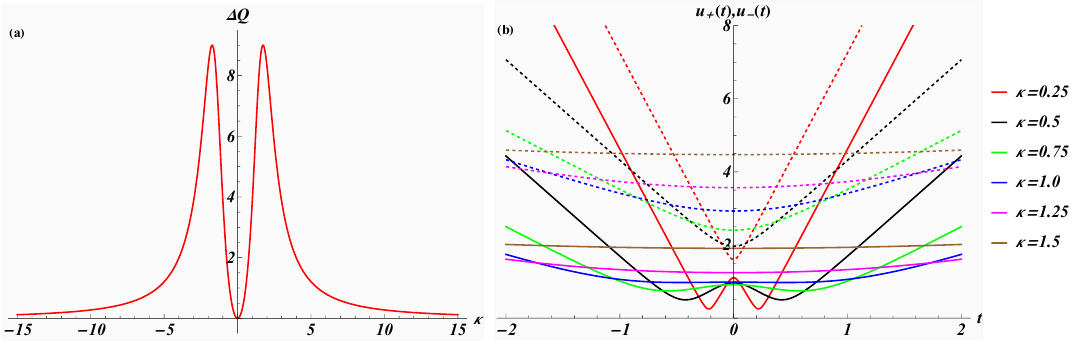
Figure 3 . Panel (a): deviation ∆ Q ( κ ) = Q ( κ ) − Q e as a functions of κ from the exact value Q e . Panel (b): exact moduli u − ( t ) (solid lines) and u + ( t ) (dashed lines) from (3.33) exhibiting triple bouncing for some values of κ .